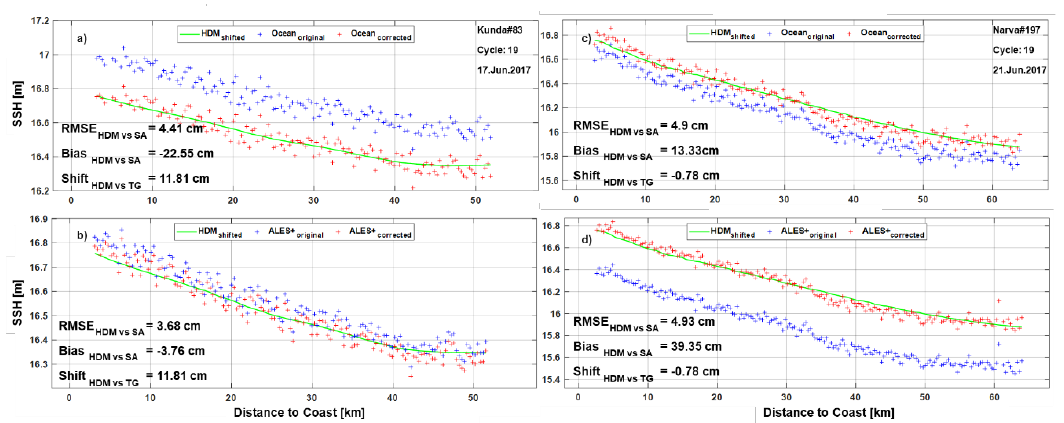
Figure 7: The along track bias per Kunda-083 (a) and Narva-Jõesuu 197 (b) stations in cycle 19 using both Ocean (top) and ALES+ SAR (bot- tom) retrackers. In this figure red crosses show the SA data points after removing the bias from initial data (blue crosses). The green line represents HDM SSH – the ground truth.